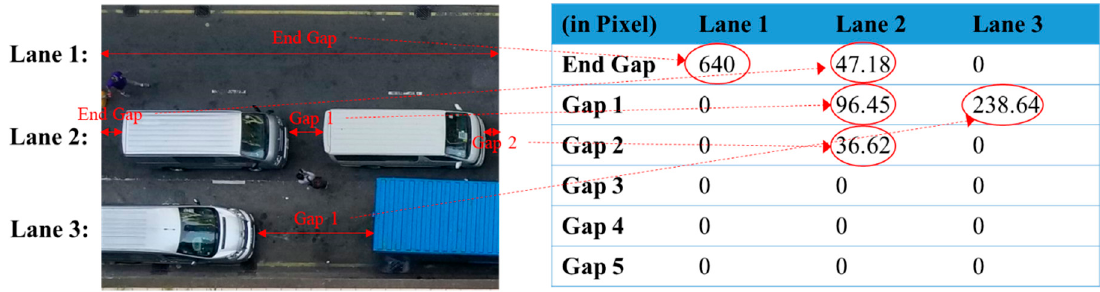
Figure 15. Parking gaps in the three individual traffic lanes.